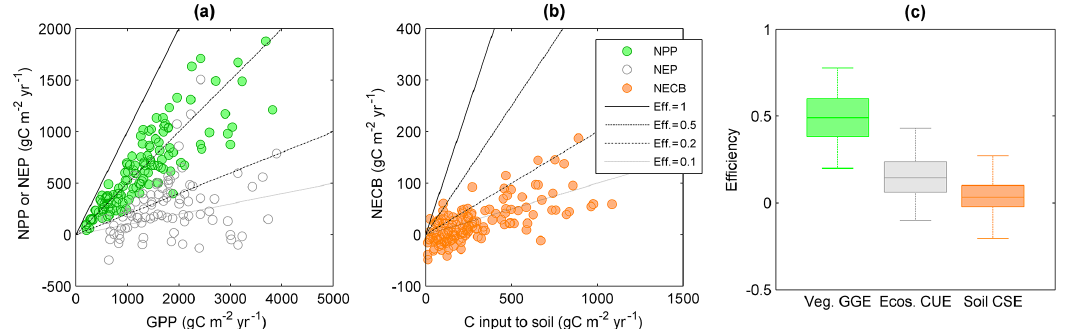
Figure 7. Relations between gross primary productivity (GPP) and (a) net primary productivity (NPP) or net ecosystem productivity (NEP), and (b) between NPP and net ecosystem C balance (NECB) in terrestrial systems. In these plots, CUE corresponds to the slopes of lines passing through the origin (four are shown for illustration). (c) Comparison of vegetation GGE, whole ecosystem CUE, and soil CSE (see also Fig. 2). Colour codes are as in Fig. 2. Data sources are described in the